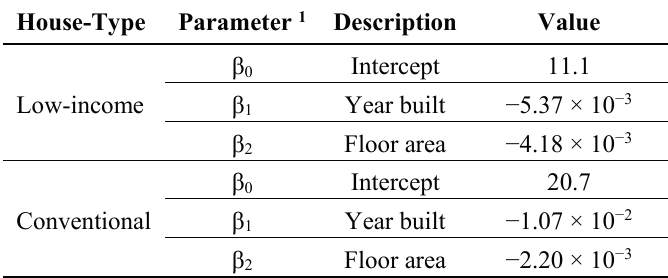
Table 3. Literature-reported leakage area model parameters for newer homes (built after